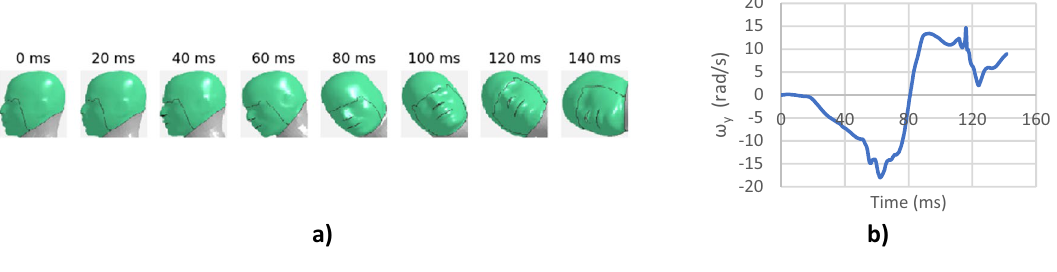
Figure 3. ( a ) Sample input, and ( b ) corresponding “ground truth” output for